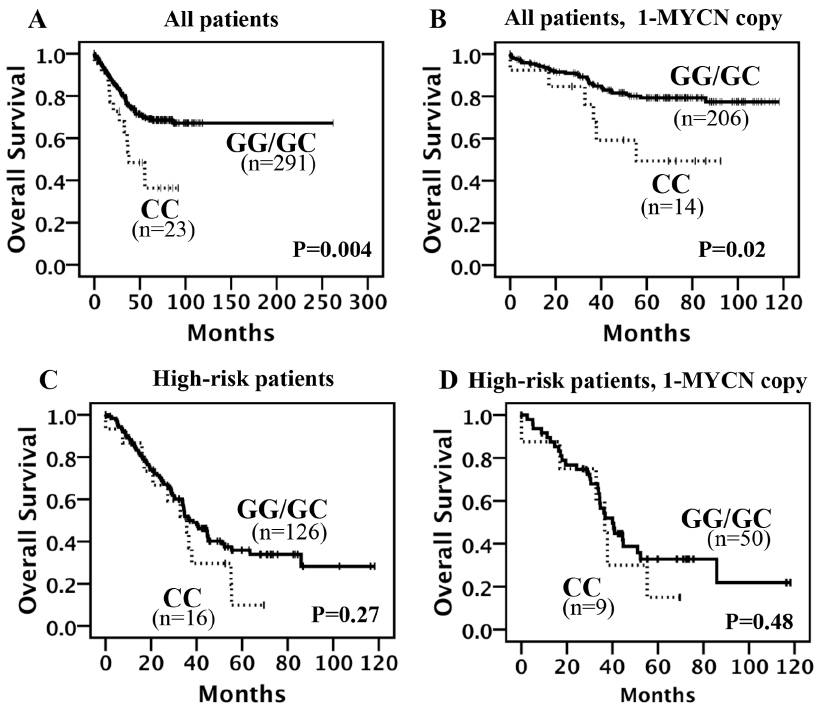
Figure 1. Kaplan-Meier curves for OS rates. OS rates were compared between CC and any G (GC or GG) for the SNP IL-6 –174 in (A) all patients, (B) in not MYCN amplified patients, (C) in high-risk patients and (D) not MYCN amplified high-risk patients.